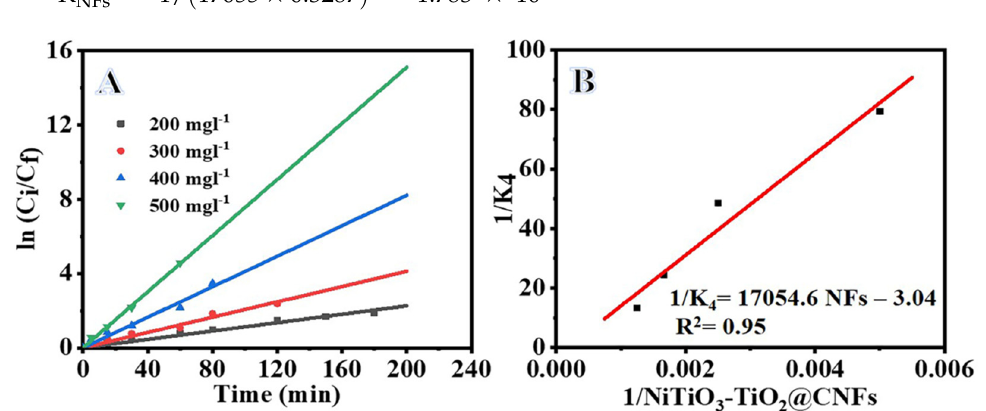
Figure 8. Influence of catalyst amount on photodegradation of MB ( A ), ln C i /C f vs. time ( B ), Langmuir-type plot for photodegradation of MB. Parameters are: C i = 0.1 M, T = 298 K, and I = 25 W m − 2 .